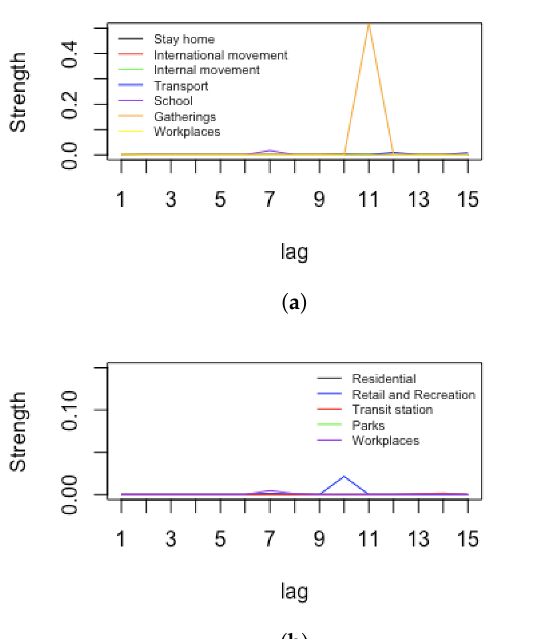
Figure 2. Strength analysis for Italy. Arc strengths according to different lags. Restriction nodes vs. hospitalisation node ( a ). Mobility nodes vs. hospitalisations node ( b